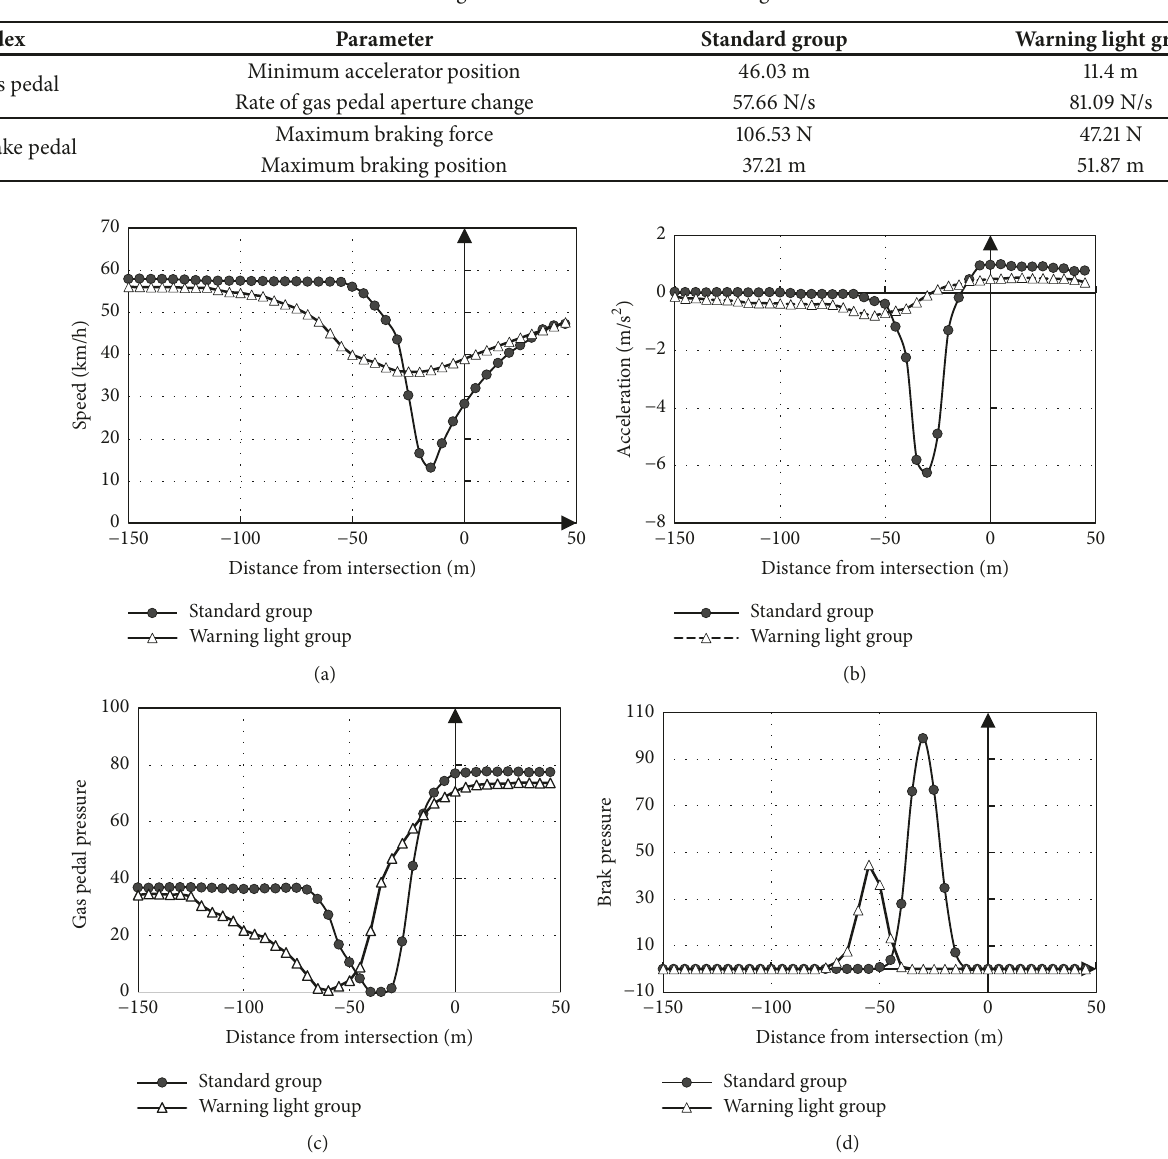
Table 5: Driving behavior under different warning scenarios.